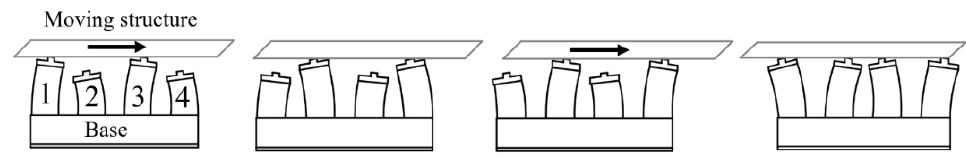
Figure 11. Schematic of a walking piezoelectric actuator.